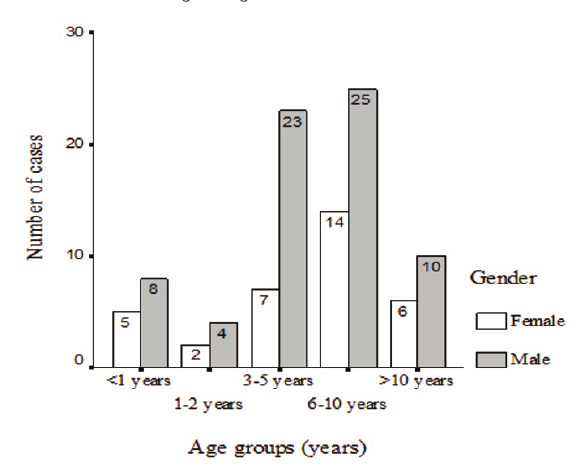
Figure 3. Yearly distribution of patients with enteroviral meningitis due to enterovirus